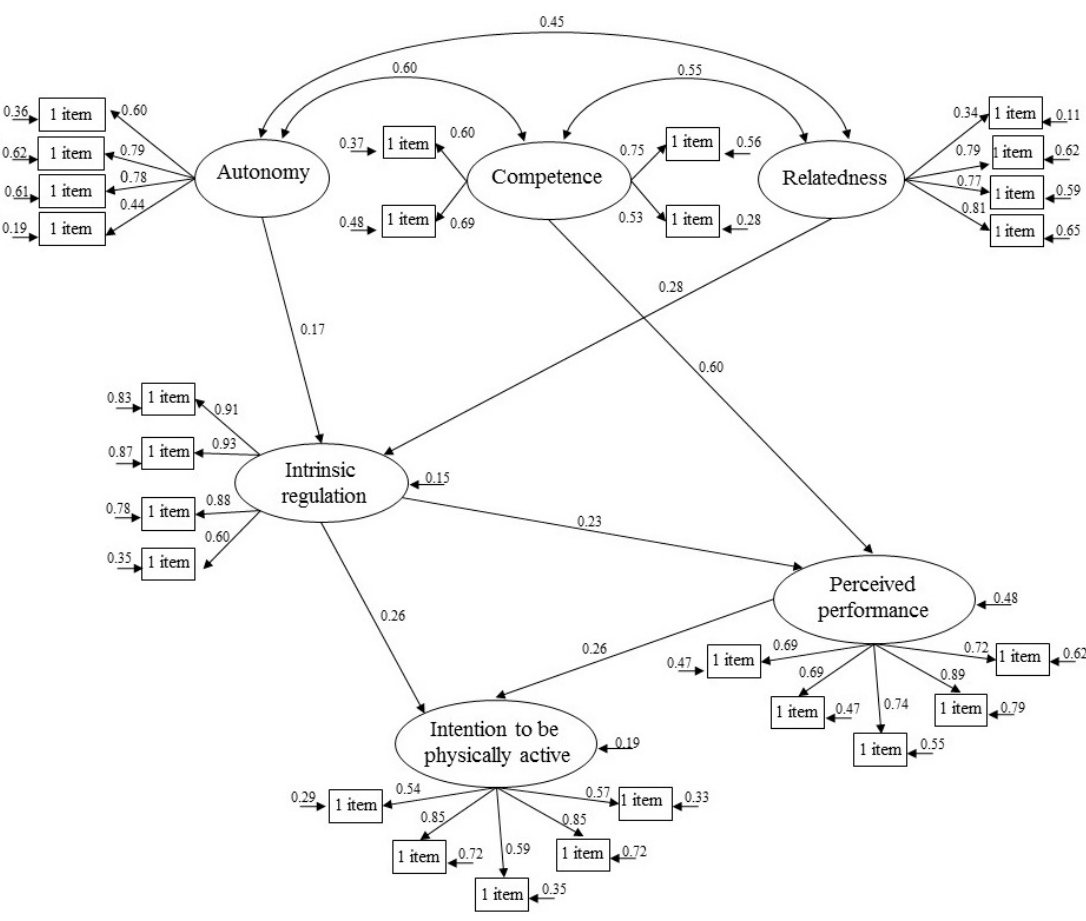
Figure 3. Structural equations model.